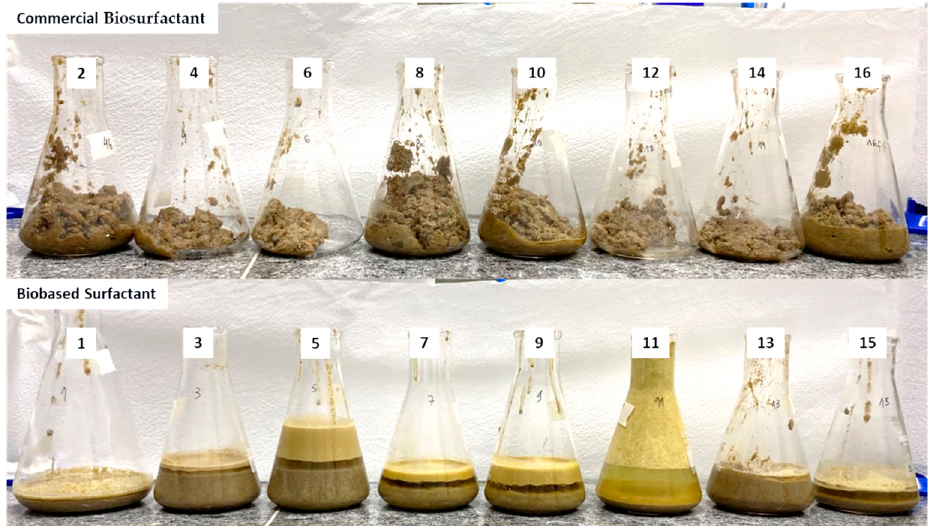
Figure 2. Images of solid portion after the experiments of motor oil removal (solid part: sand + non-removed contaminant). Numbers (1–16) correspond to experimental runs performed in 2 8-4 Fractional Factorial Design.